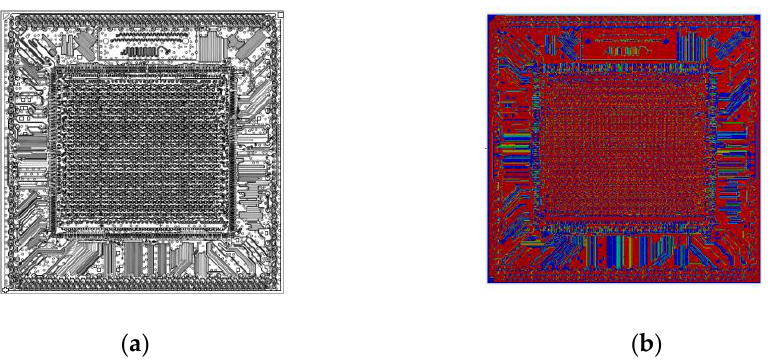
Figure 4. A flowchart of ECAD TM method.